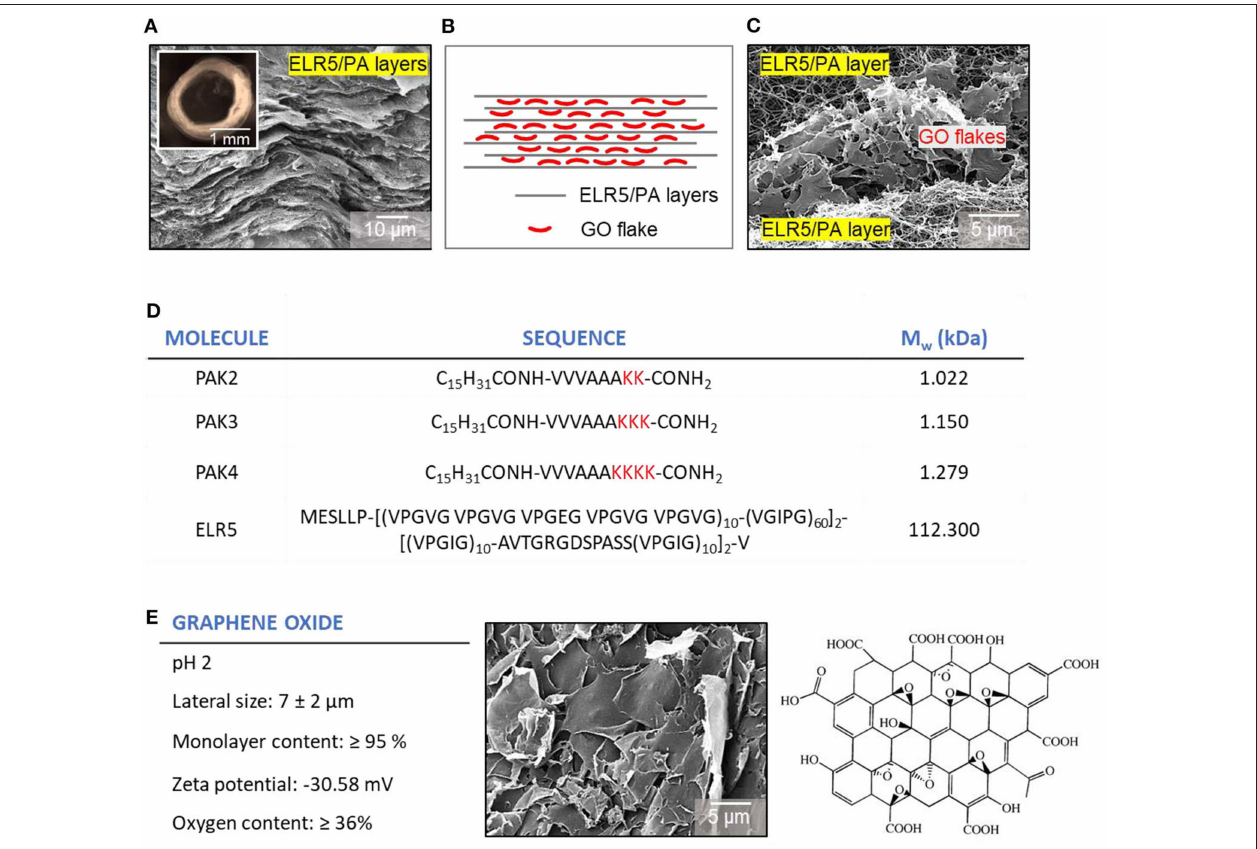
FIGURE 1 | Schematic representation and representative images of tubes and tube wall cross-sections of the ELR5/PA/GO system. (A) SEM micrograph of an ELR5/PAK3 cross-section with its characteristic multi-layered architecture. Inset: Bright field image of a top view of an ELR5/PA tube. (B) Schematic of the ELR5/PA system cross-section with black horizontal lines representing ELR5/PA layers embedded with GO flakes (red). (C) SEM micrograph of the cross-section of an ELR5/PA/GO membrane visualizing the localization of GO flakes between ELR5/PA layers. (D) Molecular structure and weight of PAs and ELR5 used in this study. (E) Molecular information and structure of GO used in this